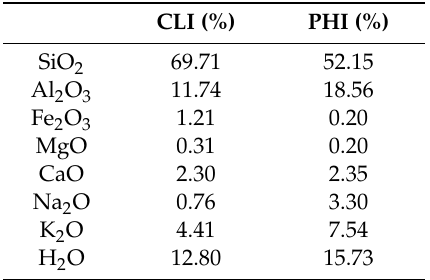
Table 1. Chemical analyses of selected samples (oxide